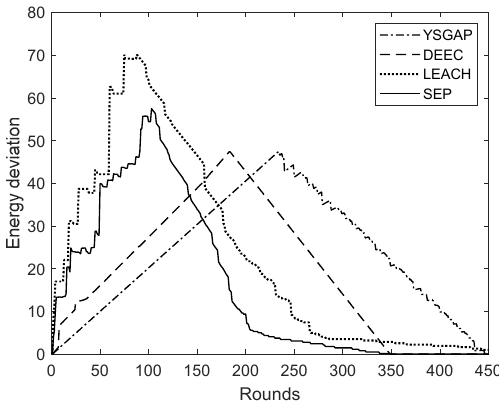
Figure 6. Energy deviation.